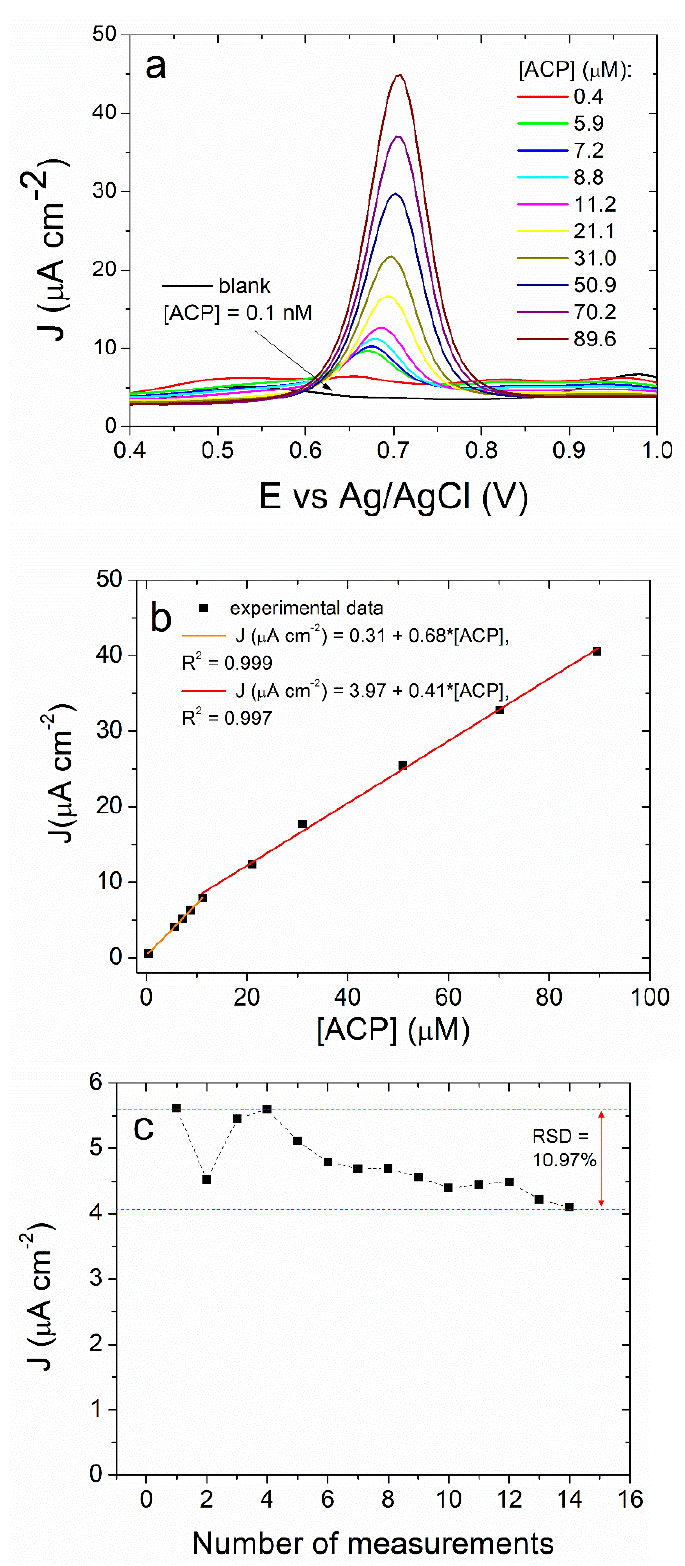
Figure 4. ( a ) DPV curves registered with the ITO/(NiTsPc/CeO 2 )-10 electrode for different concentra- tions of ACP (0.4 µ M to 89.6 µ M). ( b ) Variation of the oxidation current with the ACP concentration. ( c ) Variation of the oxidation current with the number of consecutive DPV runs for a fixed ACP concentration (10 µ M). DPV conditions: scan rate, 10 mV s − 1 ; pulse amplitude, 50 mV; pulse time: 25 ms; electrolyte: sodium acetate buffer, 0.1 M and pH 3. Table 1. Configuration and performance of different electroanalytical methods for determination of acetaminophen.